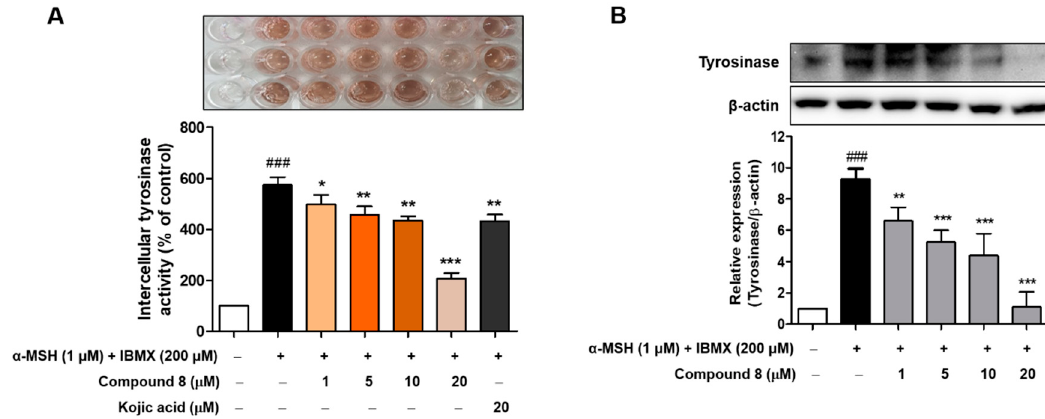
Figure 7. Effects of compound 8 on the cellular tyrosinase activities and tyrosinase levels. B16F10 cells were pretreated with compound 8 at varied concentrations (1, 5, 10 and 20 µM) or kojic acid (20 µM) for 2 h and then stimulated with α -MSH (1 µM) and IBMX (200 µM) for 48 h. Cell lysates were used for the tyrosinase activity assay ( A ) and Western blotting of the tyrosinase protein compared with β -actin ( B ). The means ± SEM of three independent experiments are presented. ### p < 0.001 vs. vehicle; * p < 0.05, ** p < 0.01 and *** p < 0.001 vs. α -MSH and IBMX-treated.